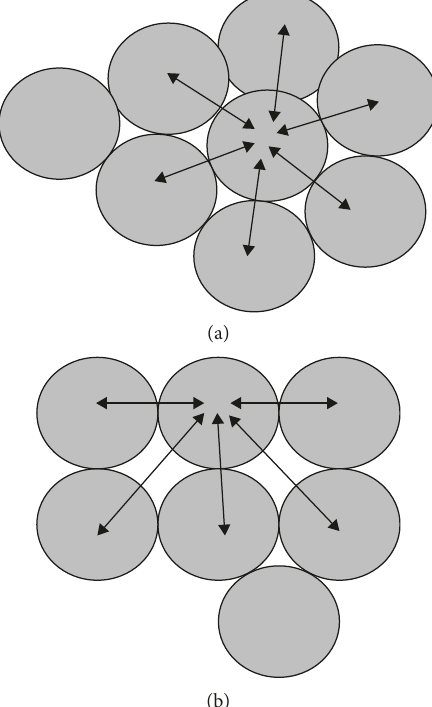
Figure 1: Differences in intermolecular forces [14]: (a) bulk; (b)